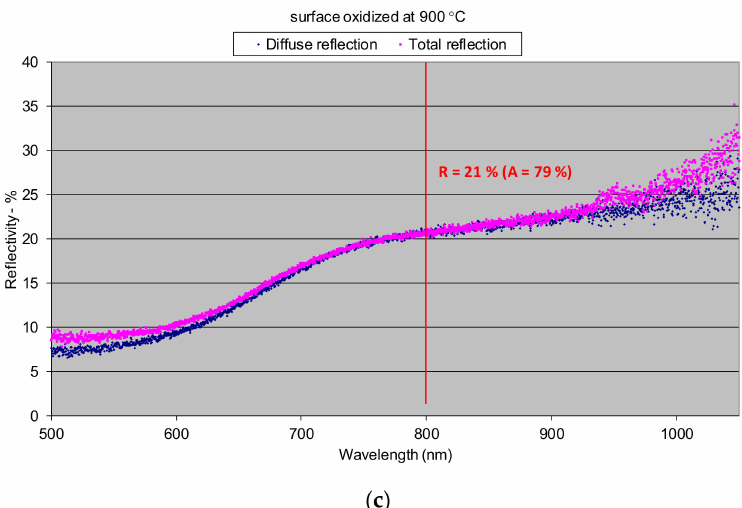
Figure 8. Reflectivity of the surfaces of titanium alloy Ti6Al4V determined at room temperature: ( a ) polished surface (surface roughness Ra 0.04); ( b ) as-received conditions (surface roughness Ra 0.4, thickness of the oxide surface layer approx. 1–2.5 µ m); ( c ) oxidized at 900 ◦ C (surface roughness Ra 25, thickness of the oxide surface layer approx. 2.5–8 µ m).